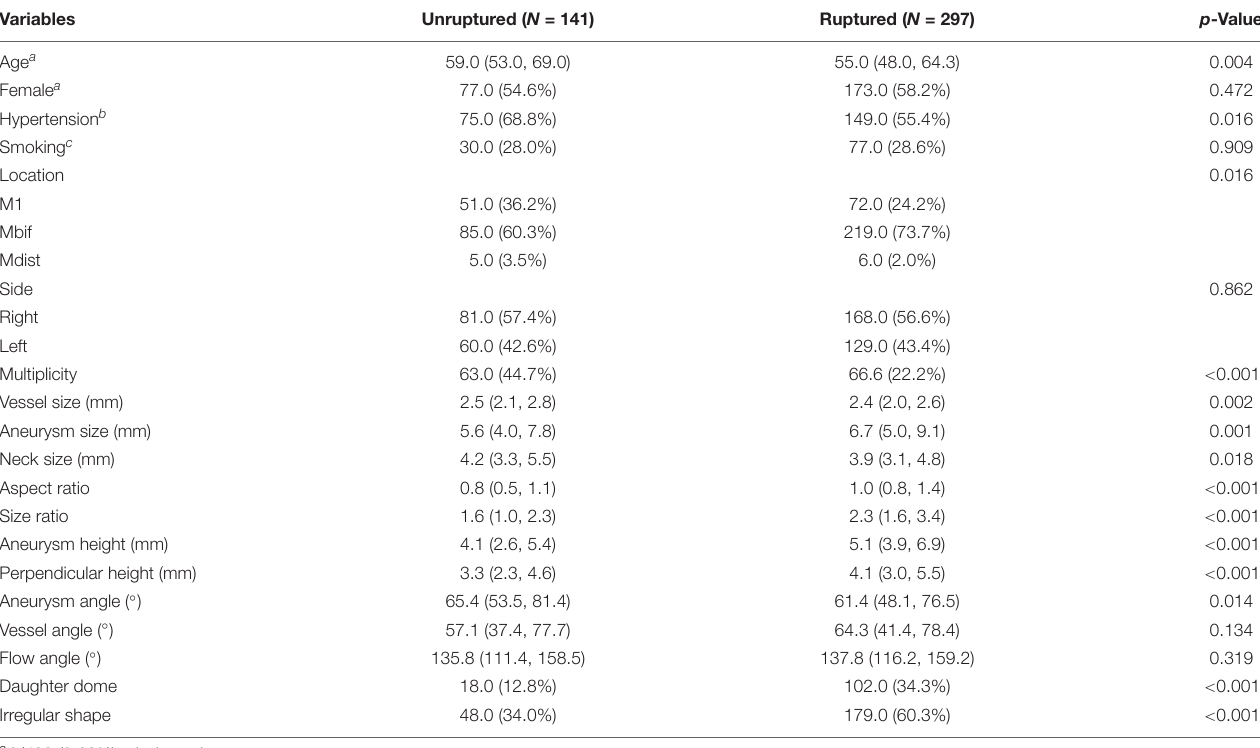
TABLE 1 | Baseline characteristics of patients in the training dataset.